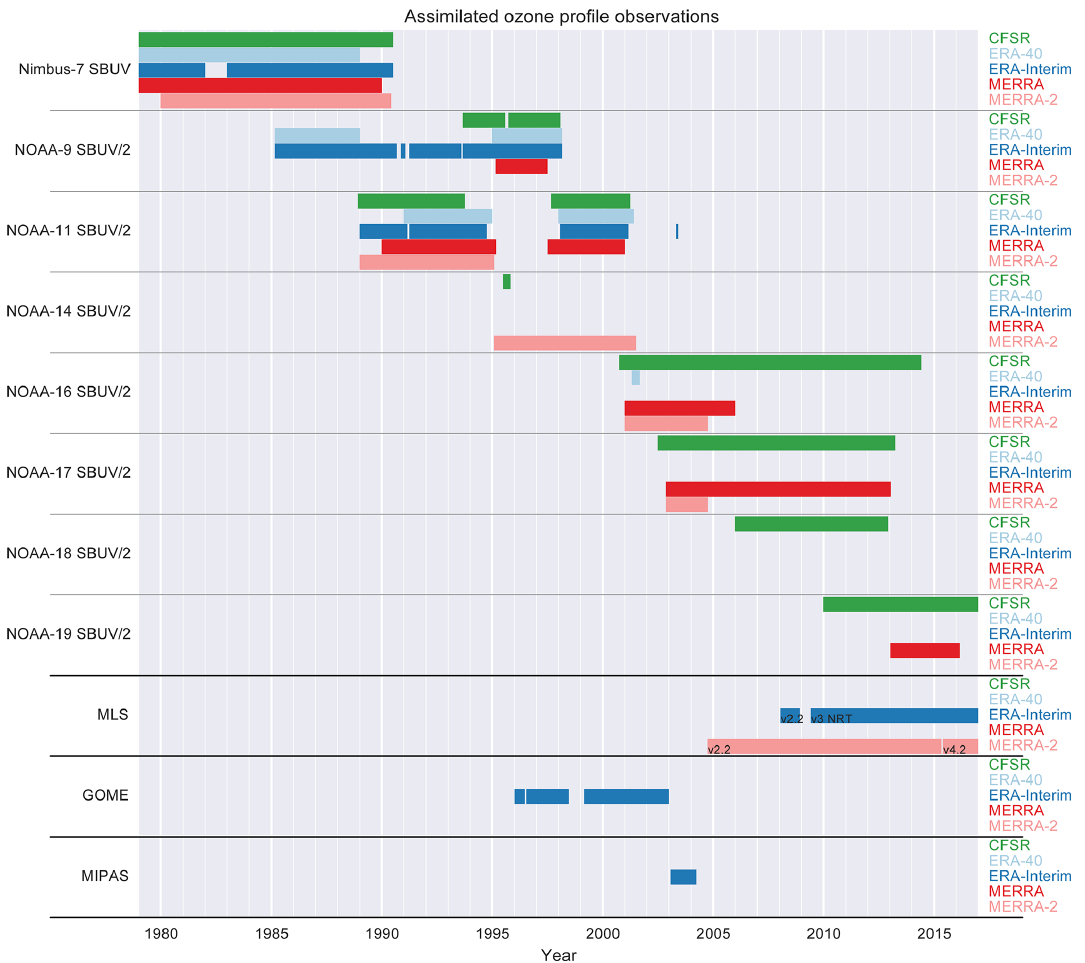
Figure 2. Ozone vertical profile observations by instrument as assimilated by the different